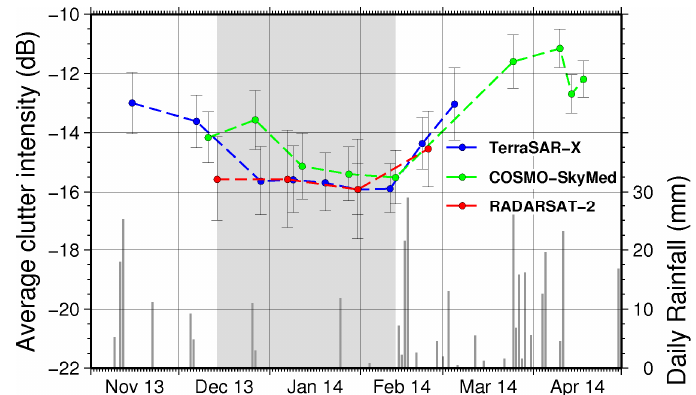
Figure 8. Time series of clutter intensity averaged over the 18 TCR sites in imagery from each SAR sensor. Error bars plot the 2-sigma standard error of the 18 observations for each image. Also plotted in the lower bar chart is the daily rainfall record for Gunning town centre, approximately 3 km away from the TCR array (data obtained from Australian Bureau of Meteorology). The grey polygon indicates a period of relatively stable radar clutter characteristics at Gunning prior to the advent of heavier rainfall events. Image acquisitions falling within this polygon (and indicated in Table 3) are further analysed in terms of RCS, SCR and LOS displacement error in the following sub-sections.